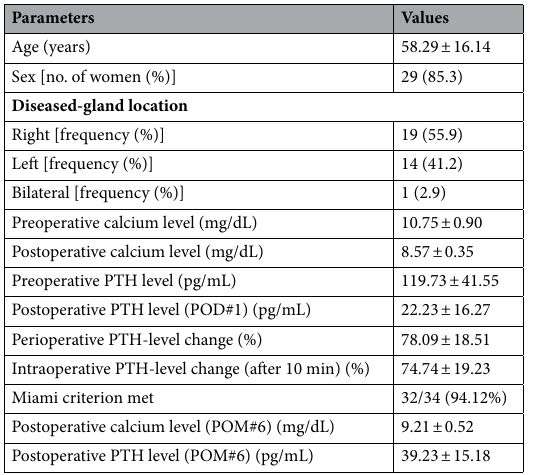
Table 1. Patient characteristics. PTH: Parathyroid hormone, POD: Post operation days, POM: Post operation months, Miami criterion: Intraoperative PTH drop ≥ 50% from the highest of either pre-incision or pre- excision level at 10 min.